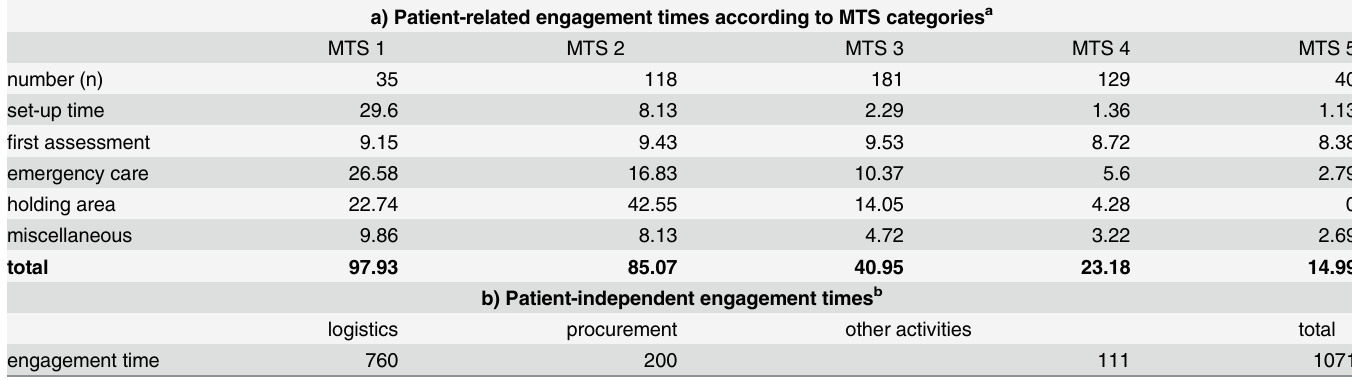
Table 1. Nurse engagement